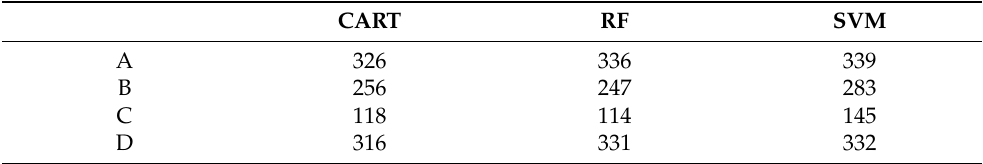
Table 4. Number of pixels identified as C&DW by each algorithm in the four study areas. CART